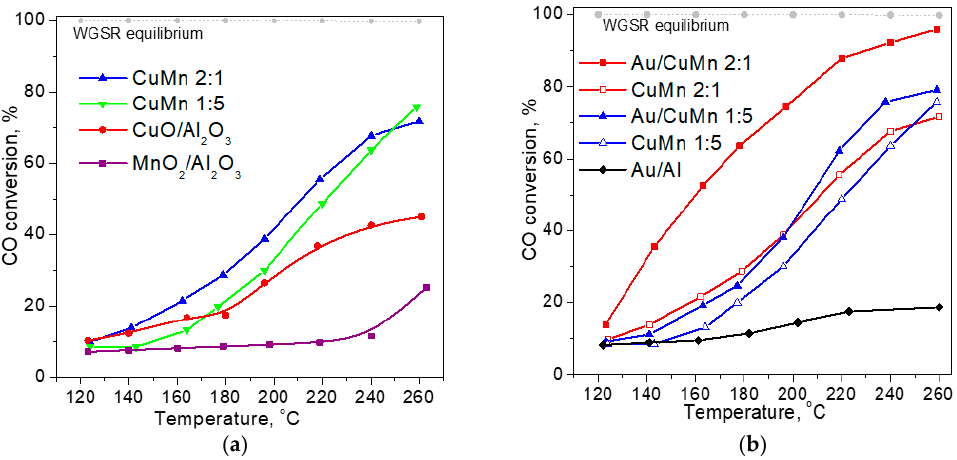
Figure 1. The temperature dependence of CO conversion during water-gas shift (WGS) reaction over ( a ) alumina-supported CuO, MnO 2 , and mixed oxides with a Cu-to-Mn molar ratio of 2:1 and 1:5; ( b ) alumina-supported Cu-Mn mixed oxides with a Cu-to-Mn molar ratio of 2:1 and 1:5, and the respective gold-promoted samples.